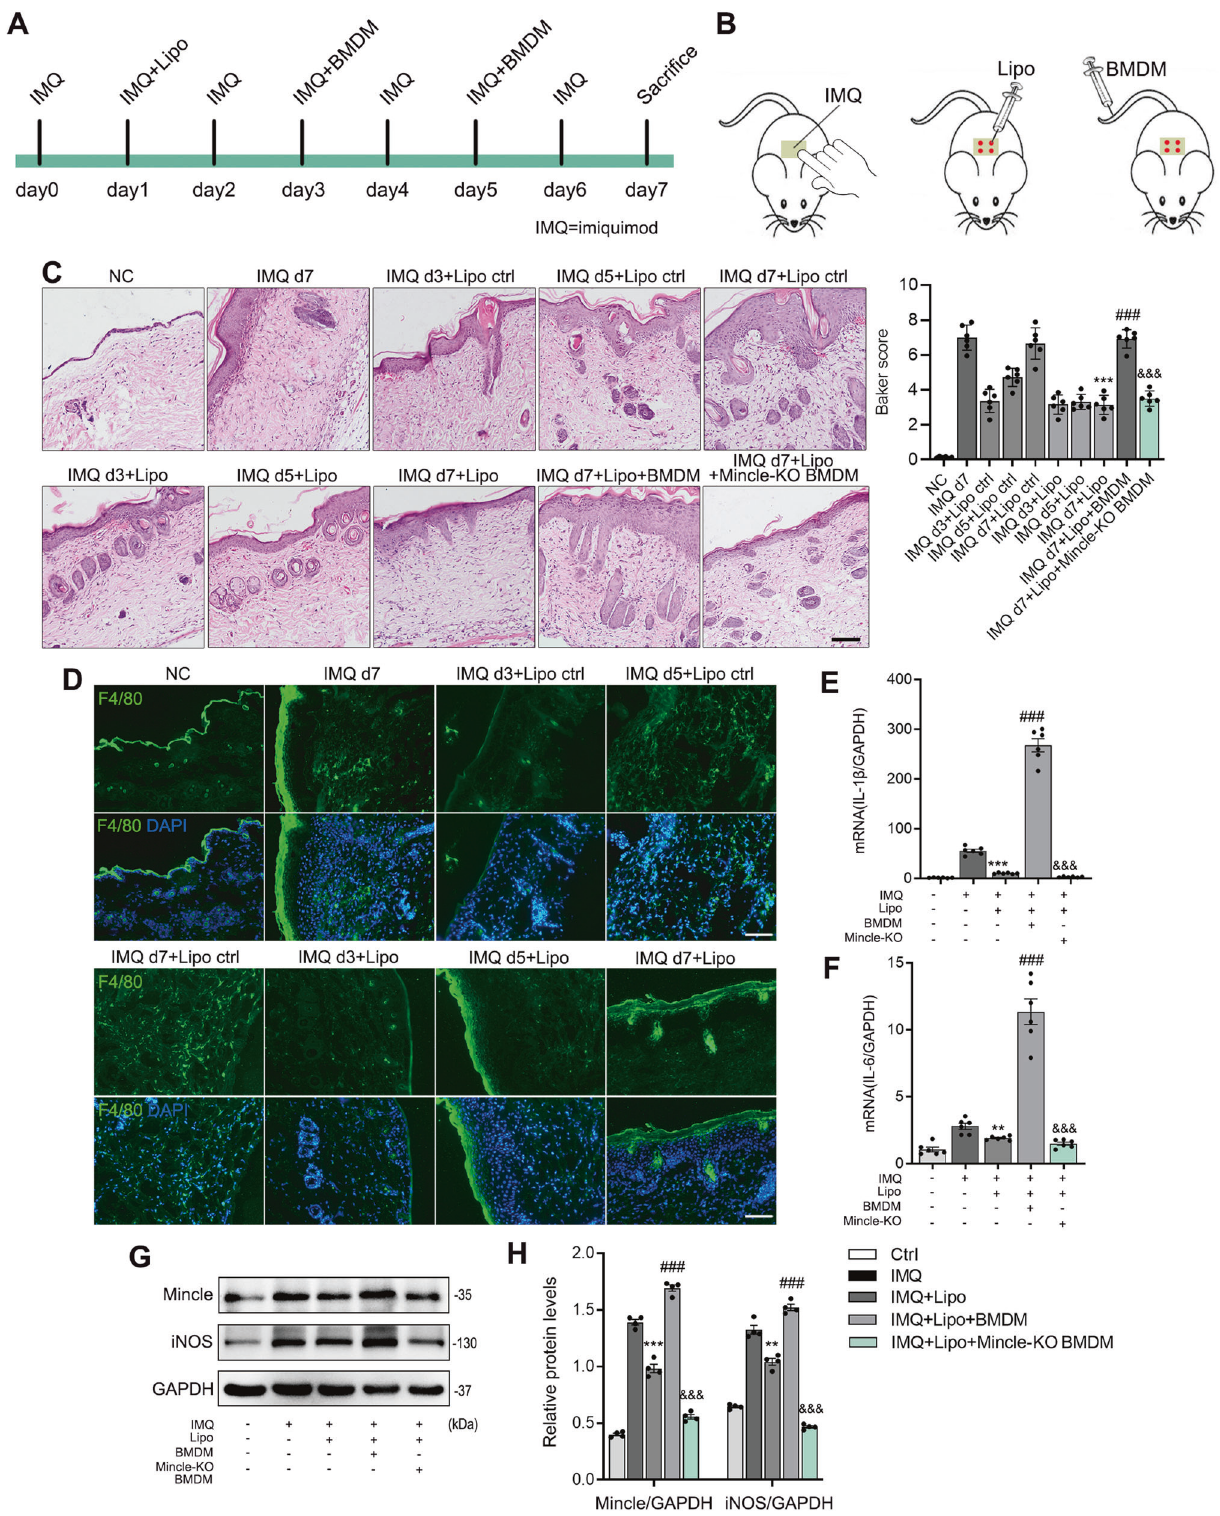
Fig. 3 Depletion of macrophages with clodronate liposomes inhibits IMQ-induced psoriasis in mice, which is restored by adoptive transfer with Mincle-expressing macrophages but not by Mincle-KO macrophages. A The timeline of injection of lipo and BMDM in psoriasis mice. B Schematic diagram of administration in mice. C H&E staining and baker score showed the histopathology of mouse skin in each group. D Representative images of immuno fl uorescence staining after removing macropahges from skin by injection of lipo. E , F The real-time PCR results of IL-1 β and IL-6 mRNA levels in each group. G , H Western blot results showed the protein levels of Mincle and iNOS in each group. n = 6 in each group. ** P < 0.01, *** P < 0.001 vs. IMQ group; ### P < 0.001 vs. IMQ + Lipo group; &&& P < 0.001 vs. IMQ + Lipo + BMDM group.